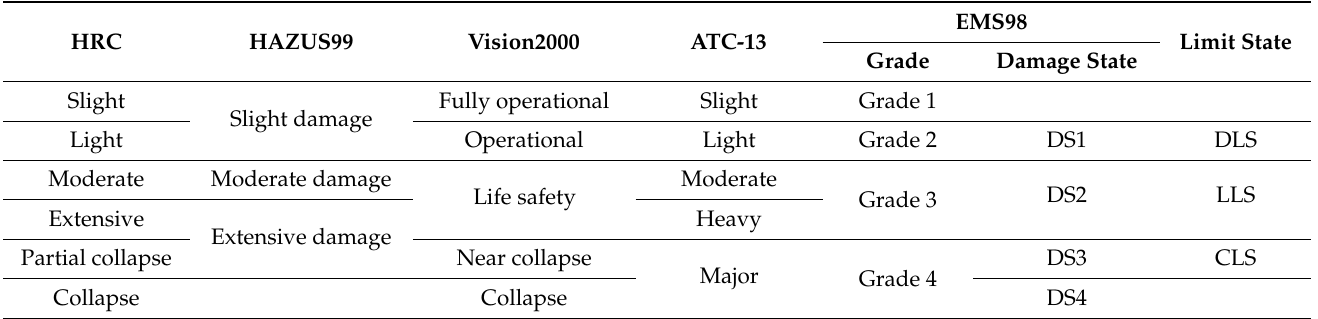
Table 2. Comparison of various damage scales and the Limit States considered in this